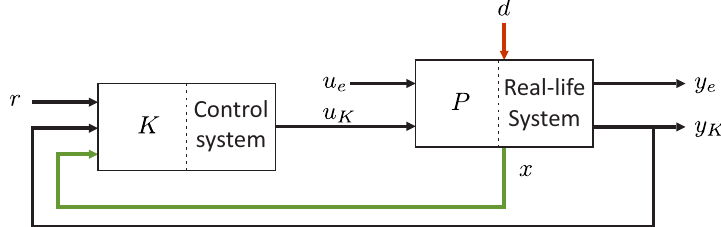
Figure 5. Block diagram representing a generic production process with a connected control